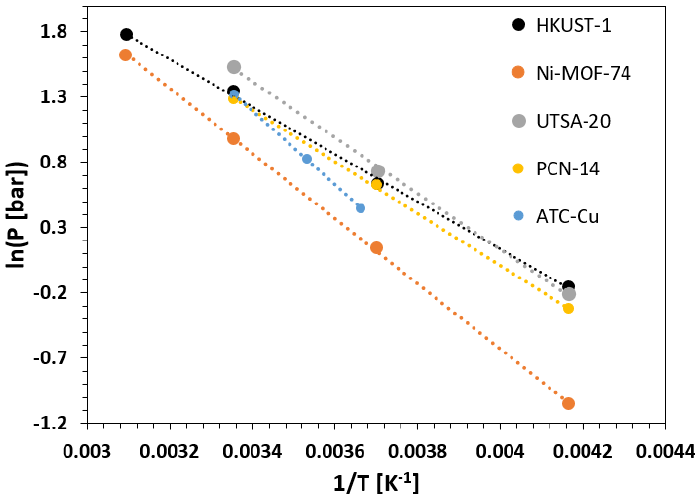
Figure 6. Plot of the natural log of the pressure in bar against inverse temperature in units of kelvin for